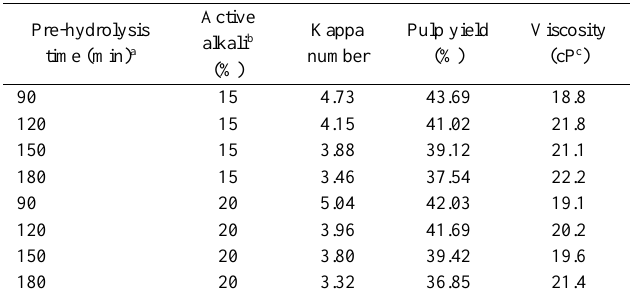
Table 2. Effects of pre-hydrolysis and AA on Soda-anthraquinone (AQ) cooking of ST